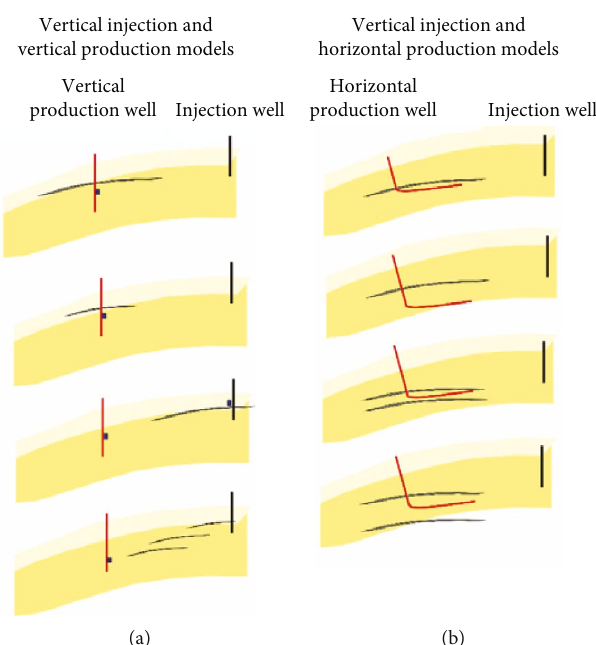
Figure 20: Schematic diagram of vertical injection and vertical production (a) and vertical injection and horizontal production (b) modes.